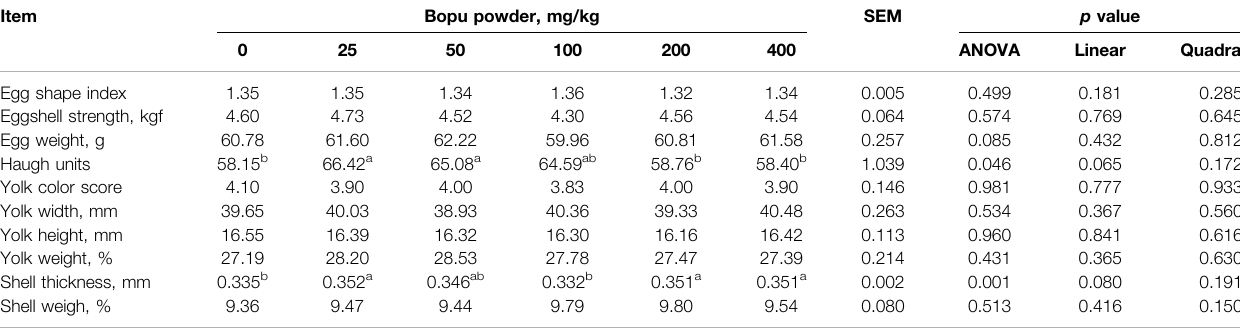
TABLE 5 | Effect of dietary Bopu powder supplementation on egg quality of laying hens (8